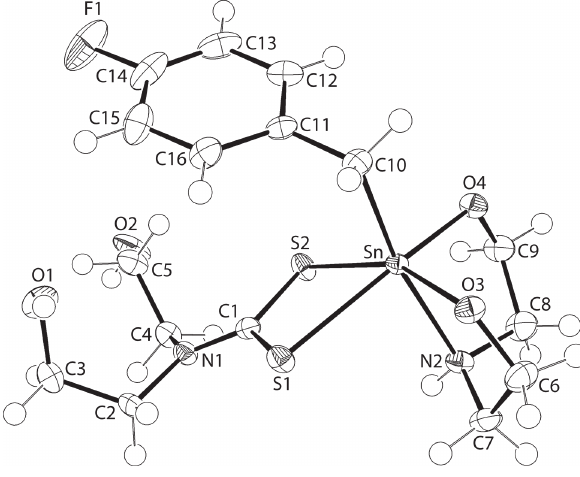
Table 1: Data collection and handling.